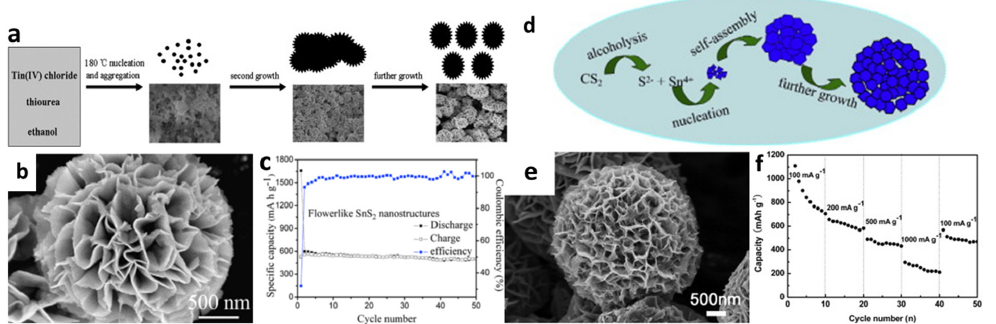
Figure 2. ( a ) Schematic illustration of the morphological evolution process, ( b ) an SEM image, and ( c ) cycling performance of the 3D flower ‐ like SnS 2 . Reprinted with permission from Ref. [66]. Copyright 2010 Elsevier. ( d ) Schematic illustration of the morphological formation process, ( e ) an SEM image, and ( f ) rate capabilities of SnS 2 hierarchitectures. Reprinted with permission from Ref. [102]. Copyright 2013 Elsevier.